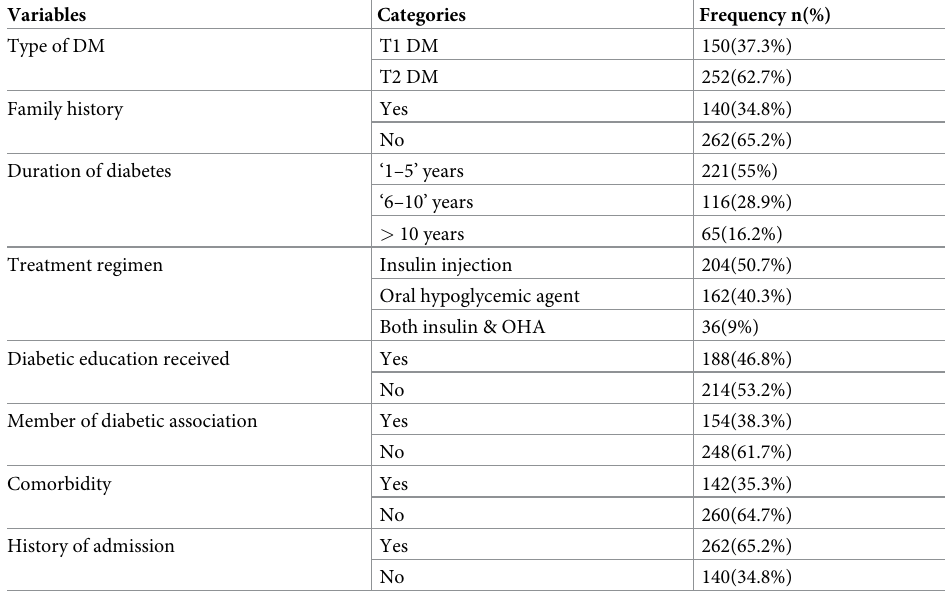
Table 2. Diabetes related clinical information of diabetic patients at the outpatient clinic of public hospitals, Bale Zone, 2021(n = 402).